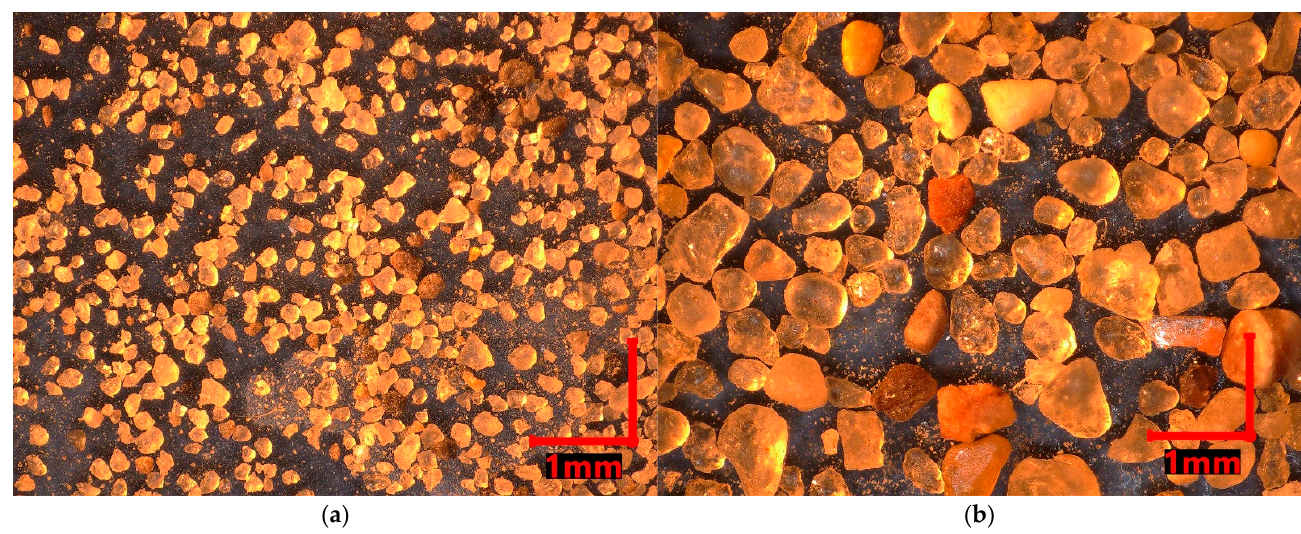
Figure 4. Microphotographs of ( a ) OZM50 tailings and ( b ) Skarpa sand grains.